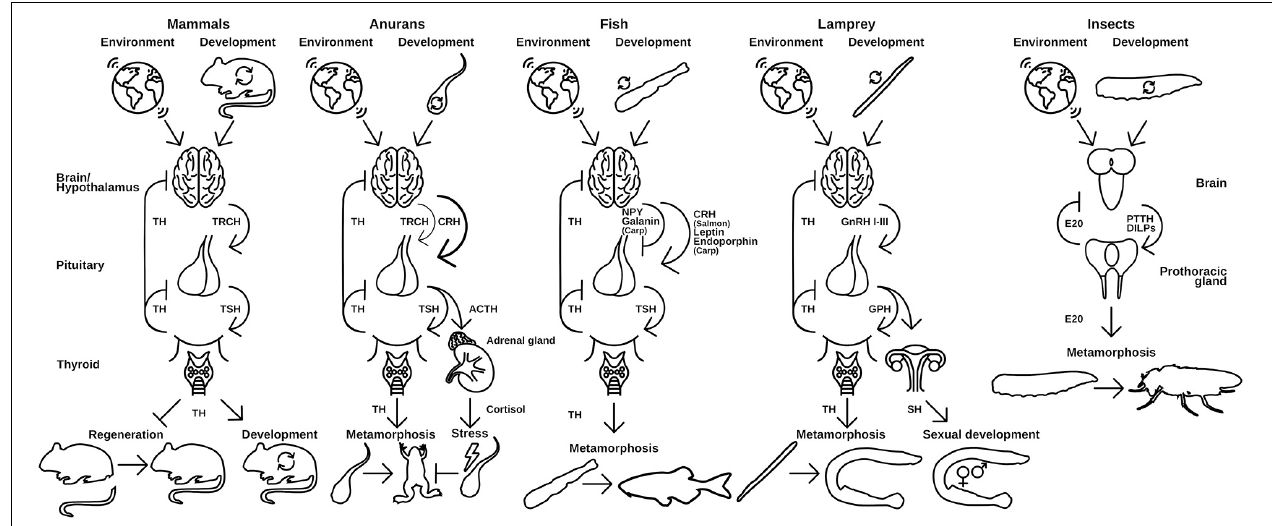
FIGURE 3 | Hypothalamus-pituitary-thyroid axis in different vertebrates use distinct releasing hormones to regulate TH release. Environmental and developmental signals control the release of releasing peptide hormones from the brain, which initiates the release of thyroid-stimulating hormones (TSH) from the pituitary gland. TSH in turn activates the production and release of TH from the thyroid. Released TH initiates and regulates metamorphic events in the animal. A similar regulation is seen in insects and the release of ecdysone (E20). PTTH and DILPS are produced in the brain after developmental and environmental cues, which induce the production of E20 in the PG. TRCH, thyroid releasing hormone; TSH, thyroid-stimulating hormone; CRH, corticotropin-releasing hormone; ACTH, adrenocorticotropic hormone; NPY, neuropeptide Y; GnRH, gonadotropin-releasing hormone; GPH, gonadal pituitary hormones; SH, sex hormones; PTTH, prothoracictropic hormone; DILP, Drosophila insulin-like peptides. Parts of the figures were derived from www.phylopic.org and www.svgrepo.com/page/licensing and are public domain or licensed under CC0 1.0.